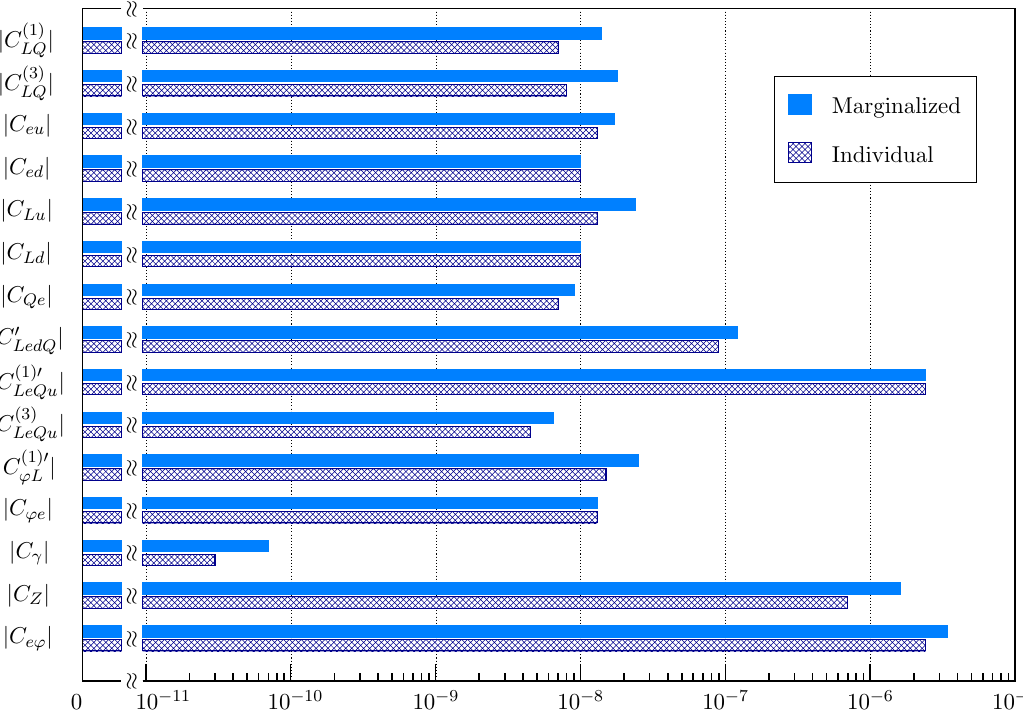
Figure 6 . Constraints on C/ Λ 2 [GeV − 2 ] based on the current Belle limits, stemming from the CLFV marginalized and individual analyses for tau decays, given at the 99.8% confidence